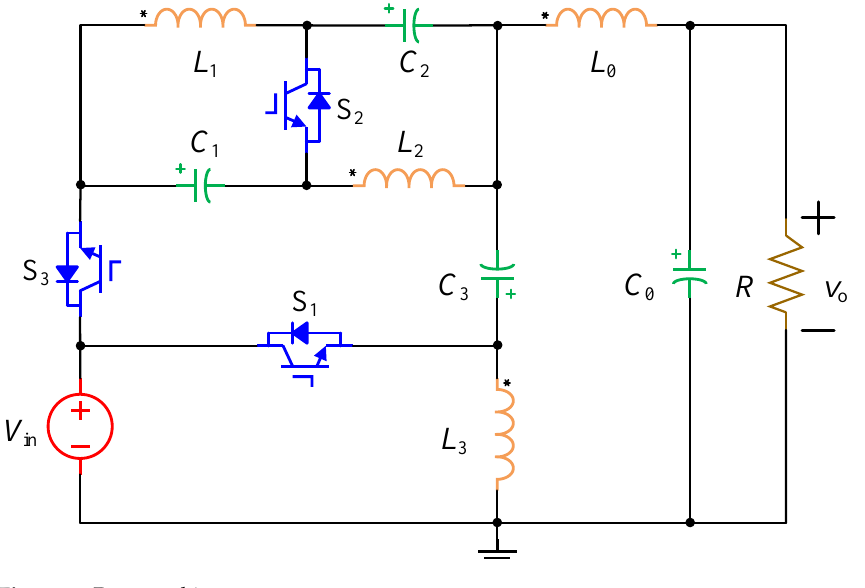
Figure 2. Proposed inverter.